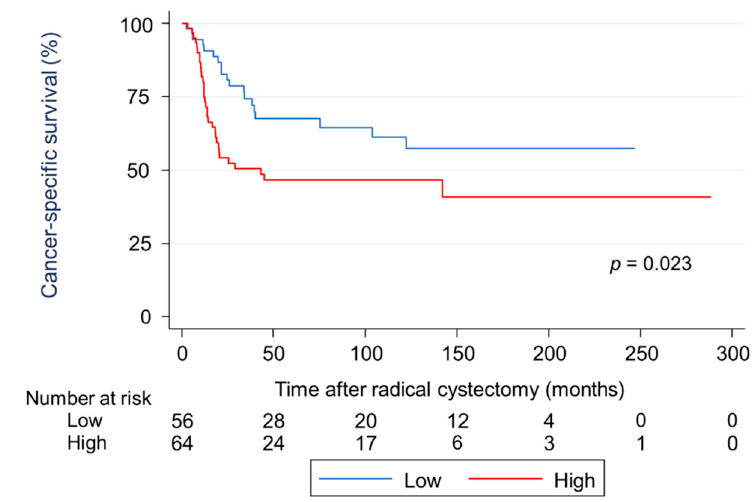
Figure 3. Survival analysis using Kaplan–Meier methods for cancer-specific survival in terms of two types of AHNAK2 expression. Patients in the high expression (HE) group showed a significantly worse cancer-specific survival than those in the low expression (LE) group.